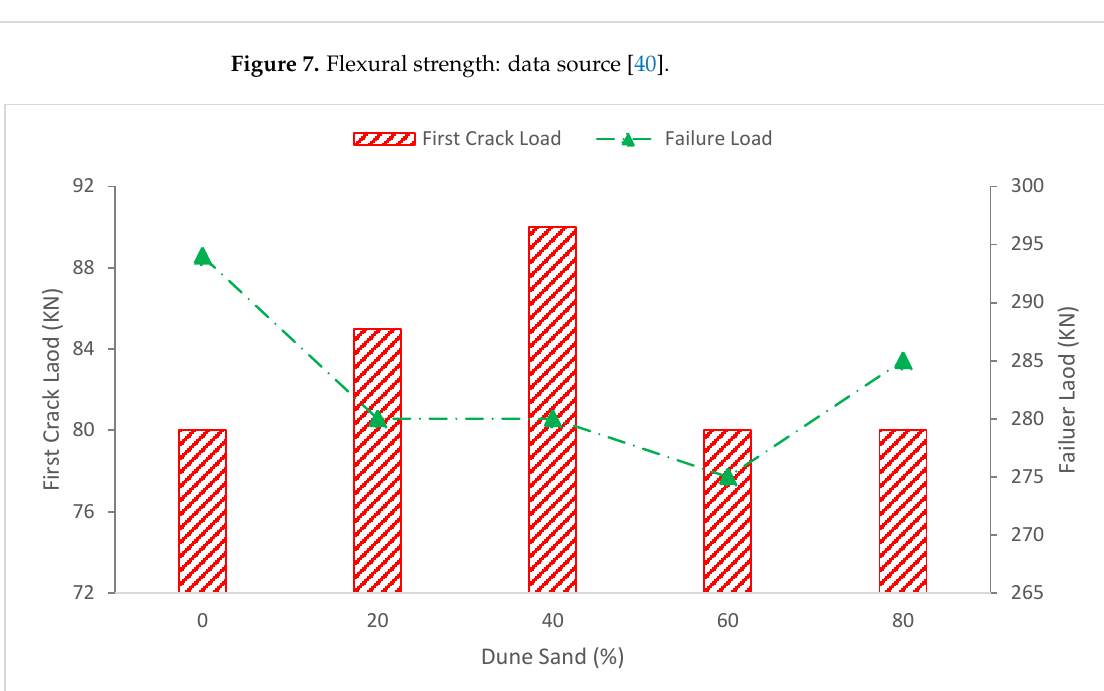
Figure 8. First crack load and failure load: data source [71].